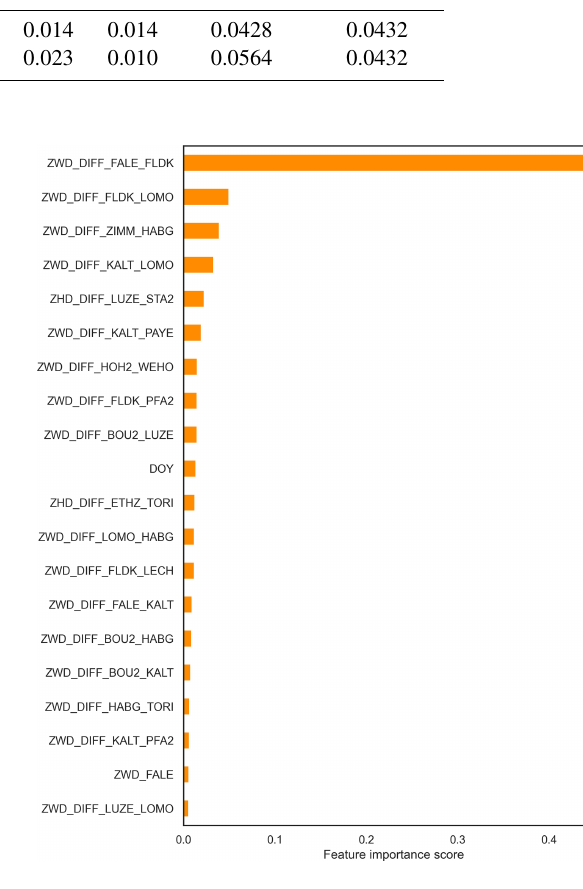
Figure 4. Feature importance score of the 20 top predictors for the GB algorithm for the setup used in FS1.